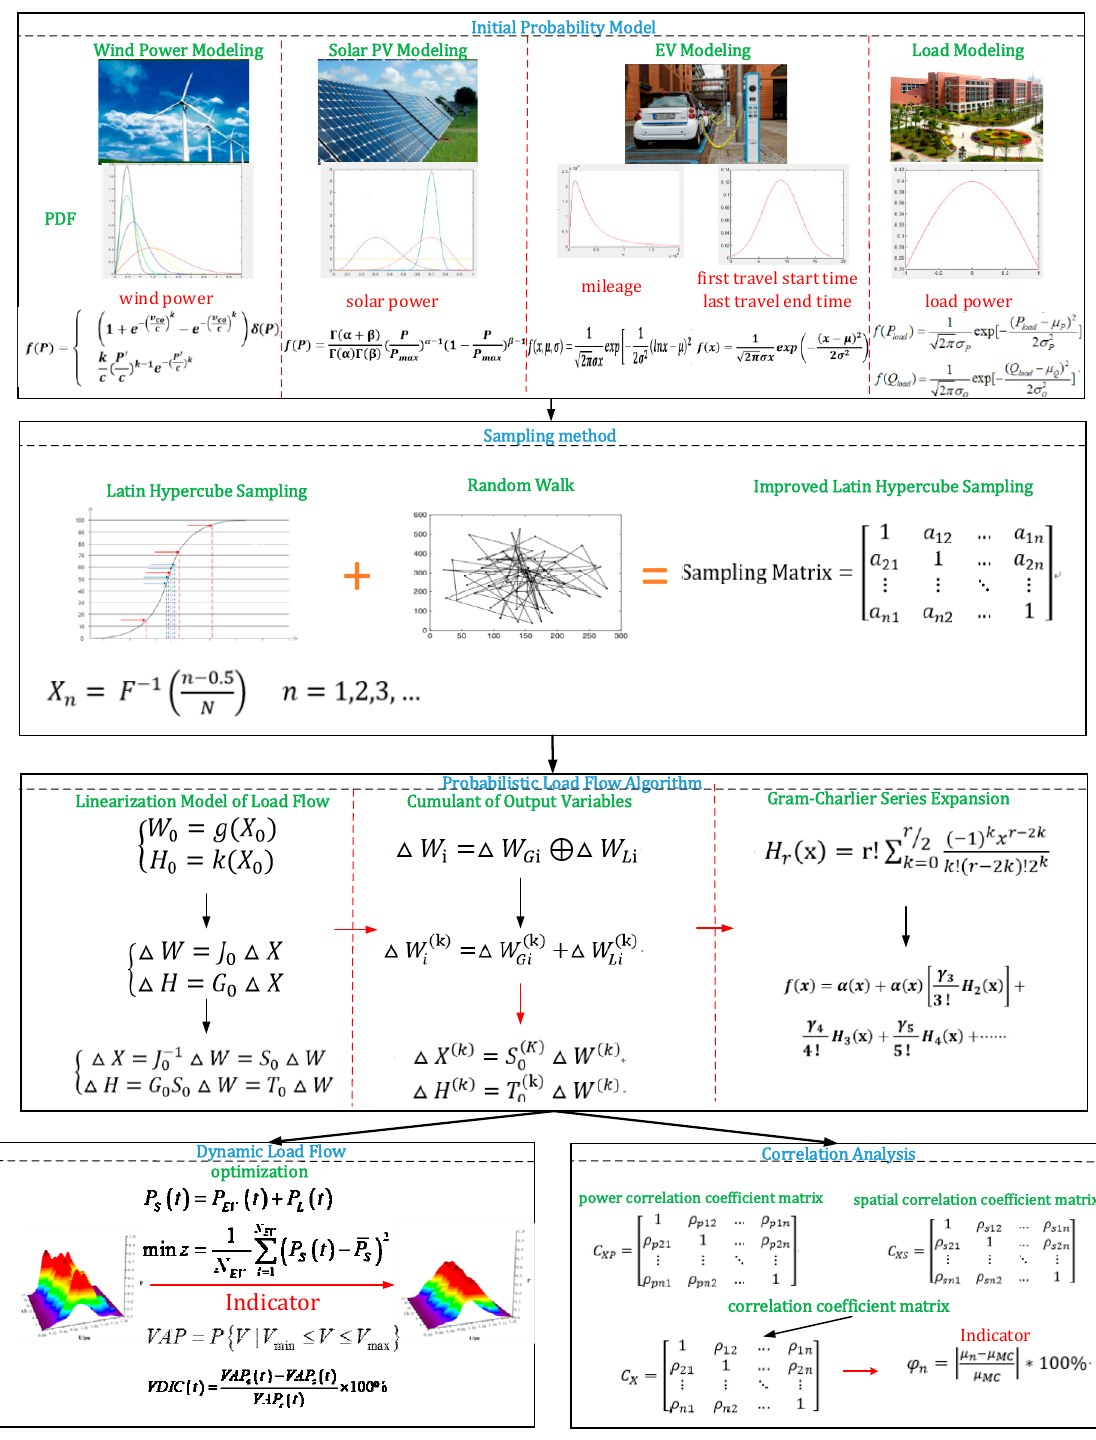
Figure 1. The organization of the proposed PLF algorithm.